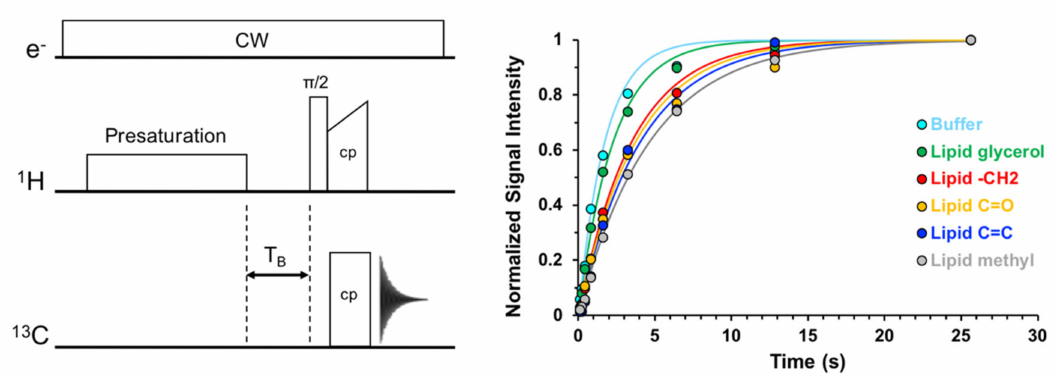
Figure 4. Pulse sequence for DNP buildup time (T B ) measurements and example data for a sample containing lipid bilayers and 10 mM AMUPol as the polarizing